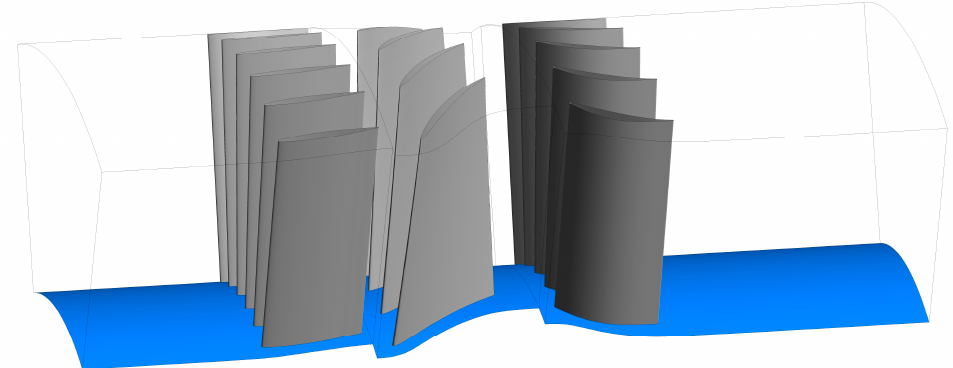
Figure 2. Full geometry of the investigated case. The gray parts are the vanes and the blue parts are the hubs.